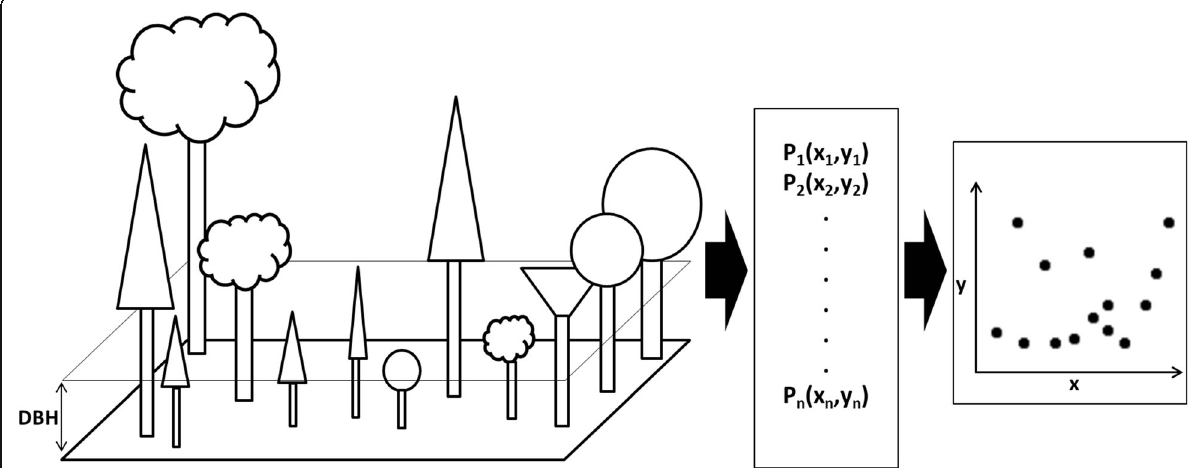
Fig. 1 Conversion of field data ( a ) to a list of points coordinates ( b ) then to a point pattern ( c ) (Modified from Goreaud 2000). In the sampled area, each plant is represented by its Cartesian coordinates ( x , y ) which serve as a basis to represent stand spatial